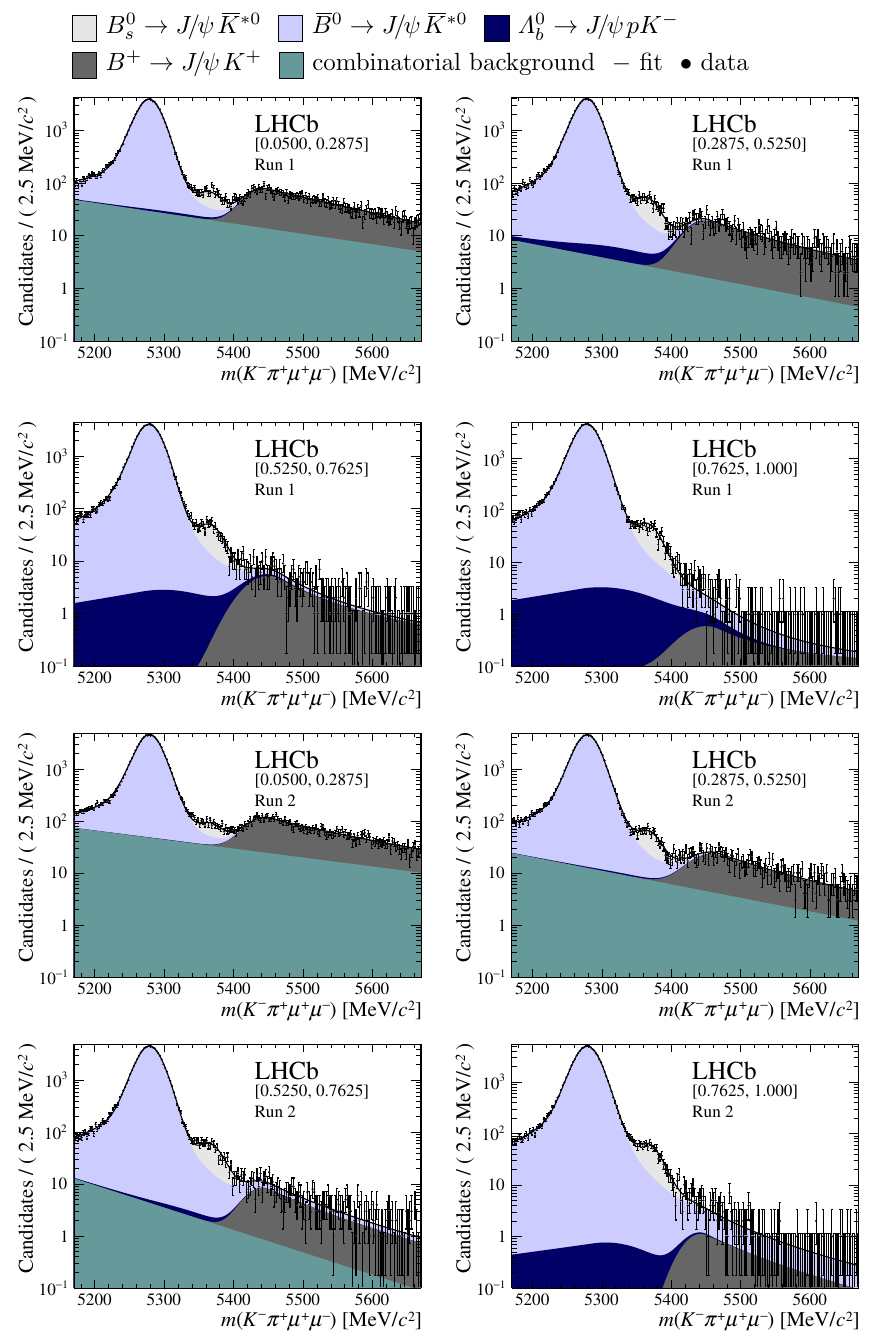
Figure 4 . Distribution of reconstructed K (cid:0) (cid:25) + (cid:22) + (cid:22) (cid:0) invariant mass of candidates in the J= mass window in (top four (cid:12)gures) the Run 1 and (bottom four (cid:12)gures) Run 2 data sets. The candidates are divided into four independent bins of increasing neural network response per data taking period.